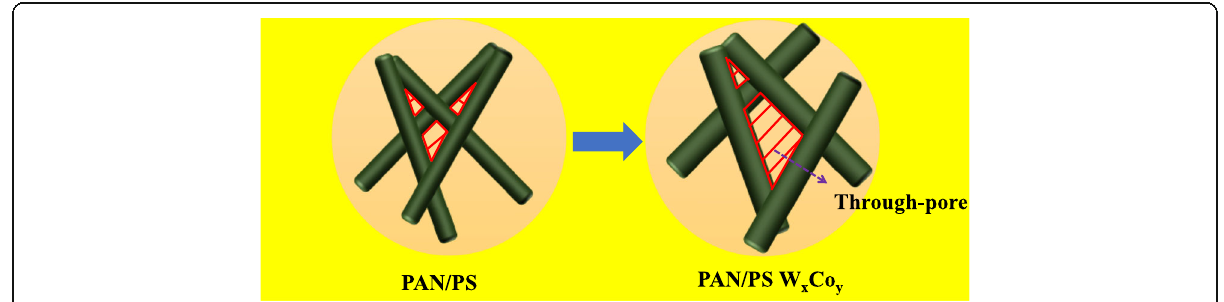
Fig. 8 Schematic of through-pore change of AMT/Co(acac) 3 -loaded PAN/PS micro-nanofibers